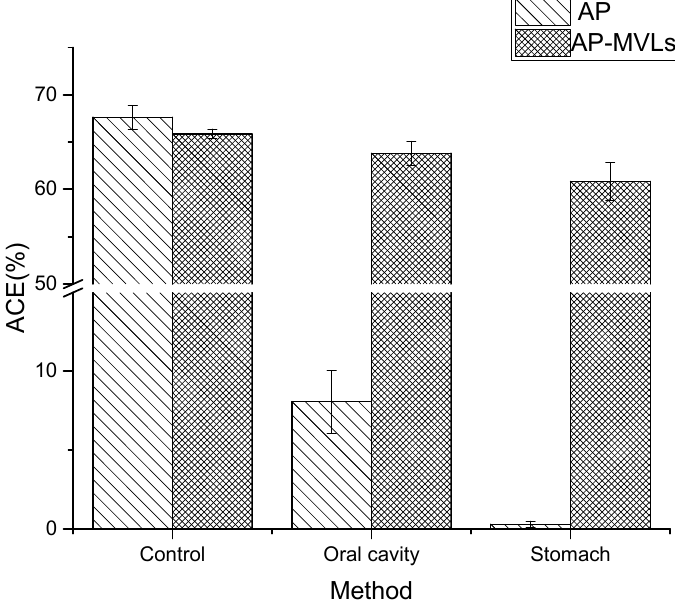
Figure 7. Digestive stability of AP and AP-MVLs.